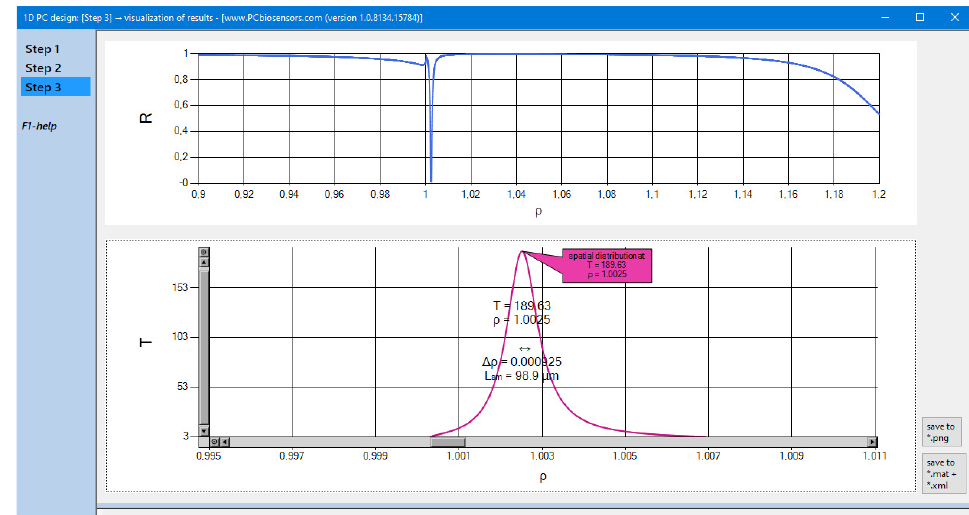
Figure 5. Reflection and transmission in Step 3 program’s window.